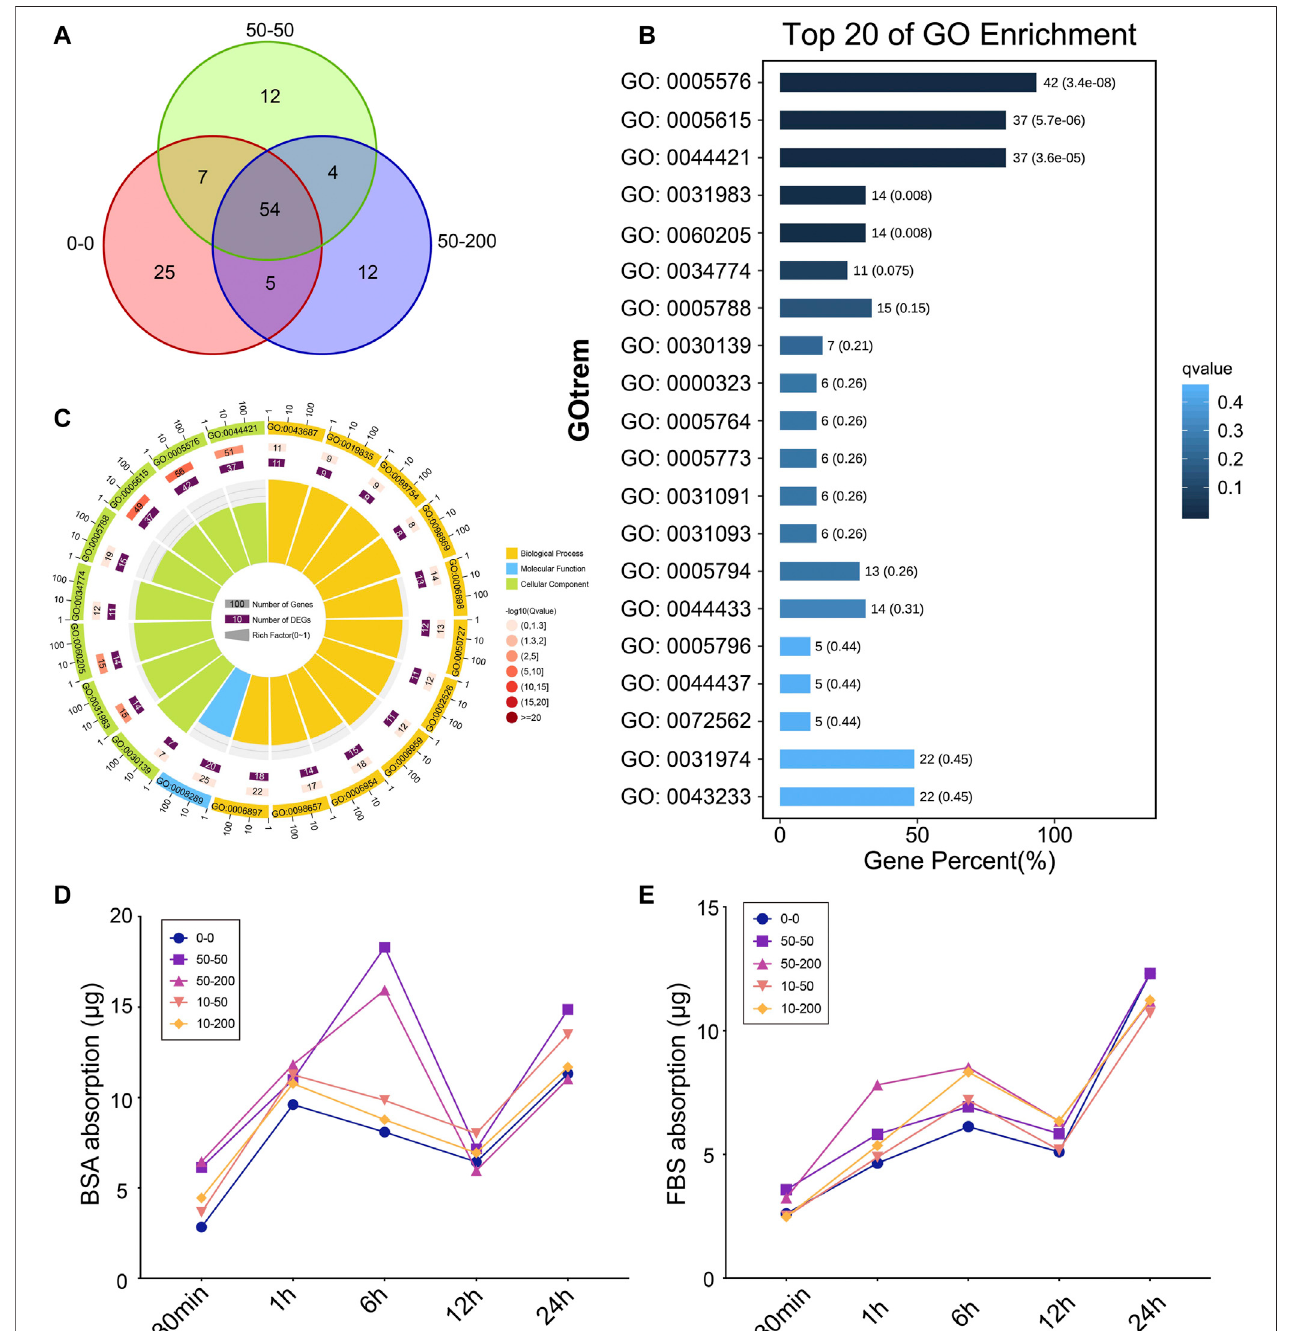
FIGURE 3 | Surface topology affects protein adsorption. (A) Protein adsorption quantity analysis based on mass spectrometry. (B) Top 20 of GO enrichment analysis. (C) Circle maps of GO analysis. (D) BSA protein adsorption capacity. (E) FBS protein adsorption capacity.